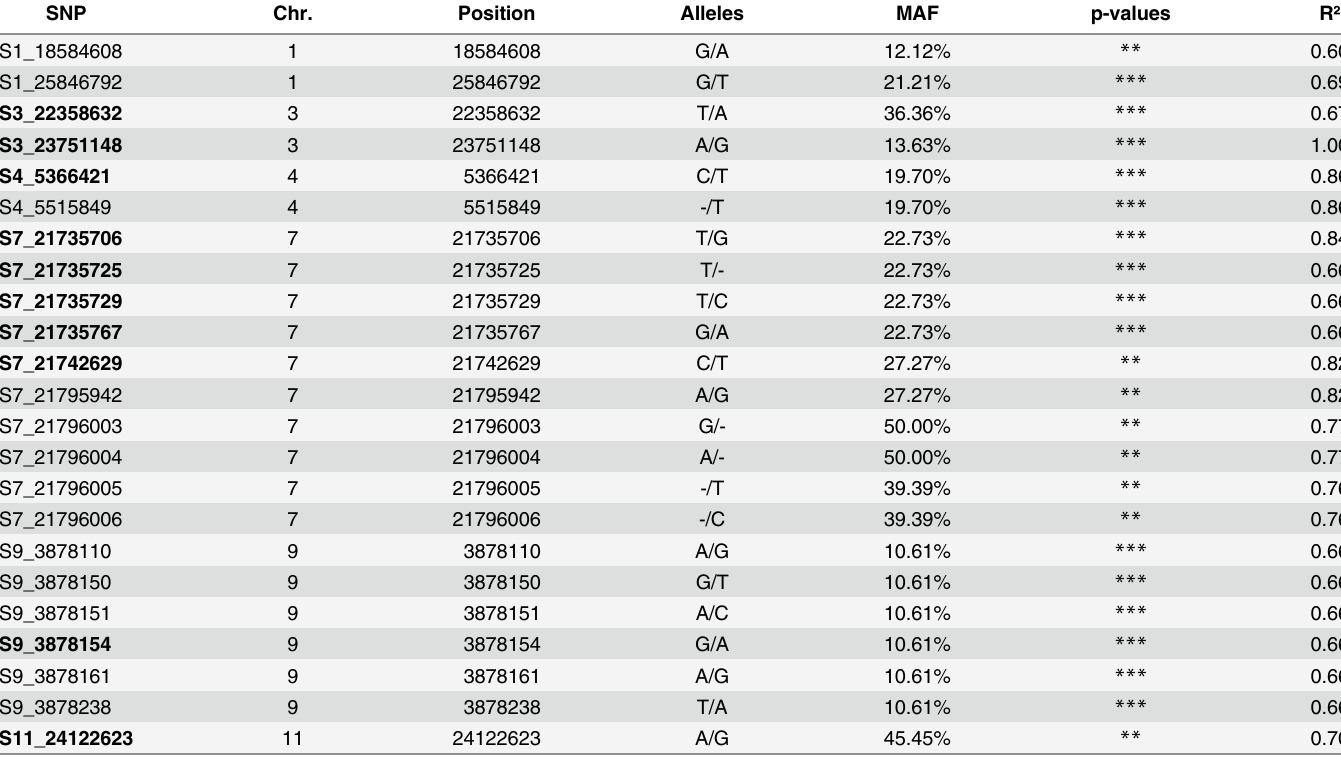
Table 4. SNPs statistically associated to the seedless phenotype when analyzing the subset with the MLM K and corresponding range of p-values obtained. SNPs in bold are those commonly detected when anlyzing the panel. R² is the proportion of phenotypic variance explained by the markers. SNP Chr. Position